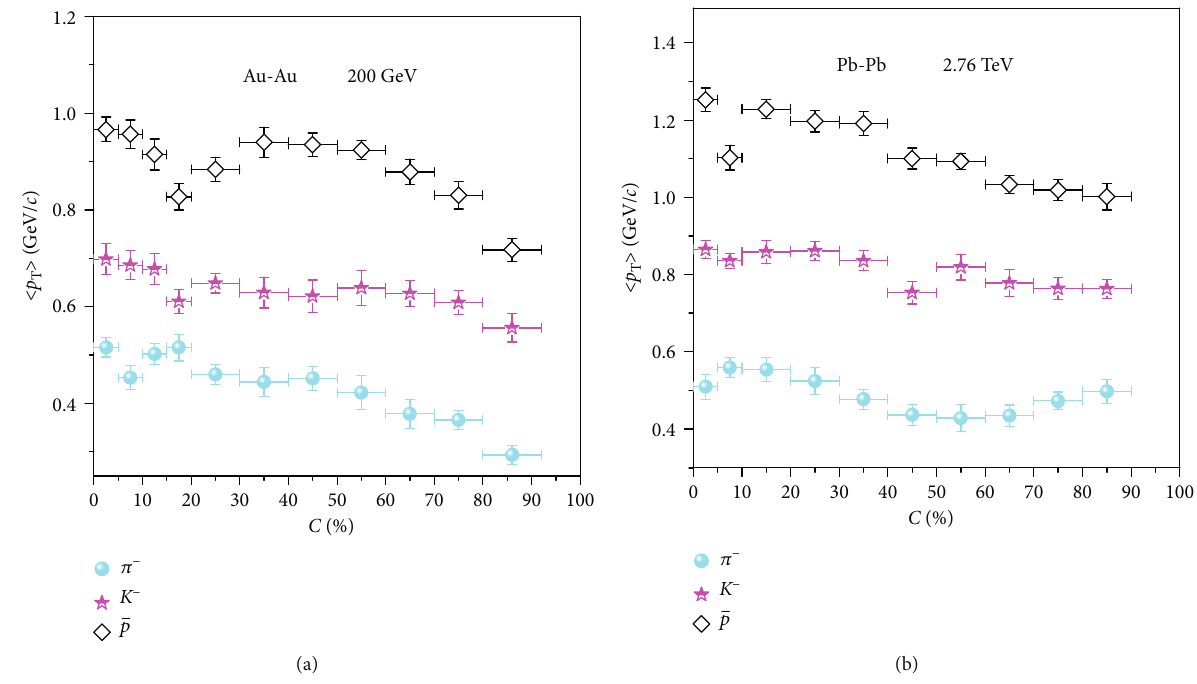
i on centrality C . T